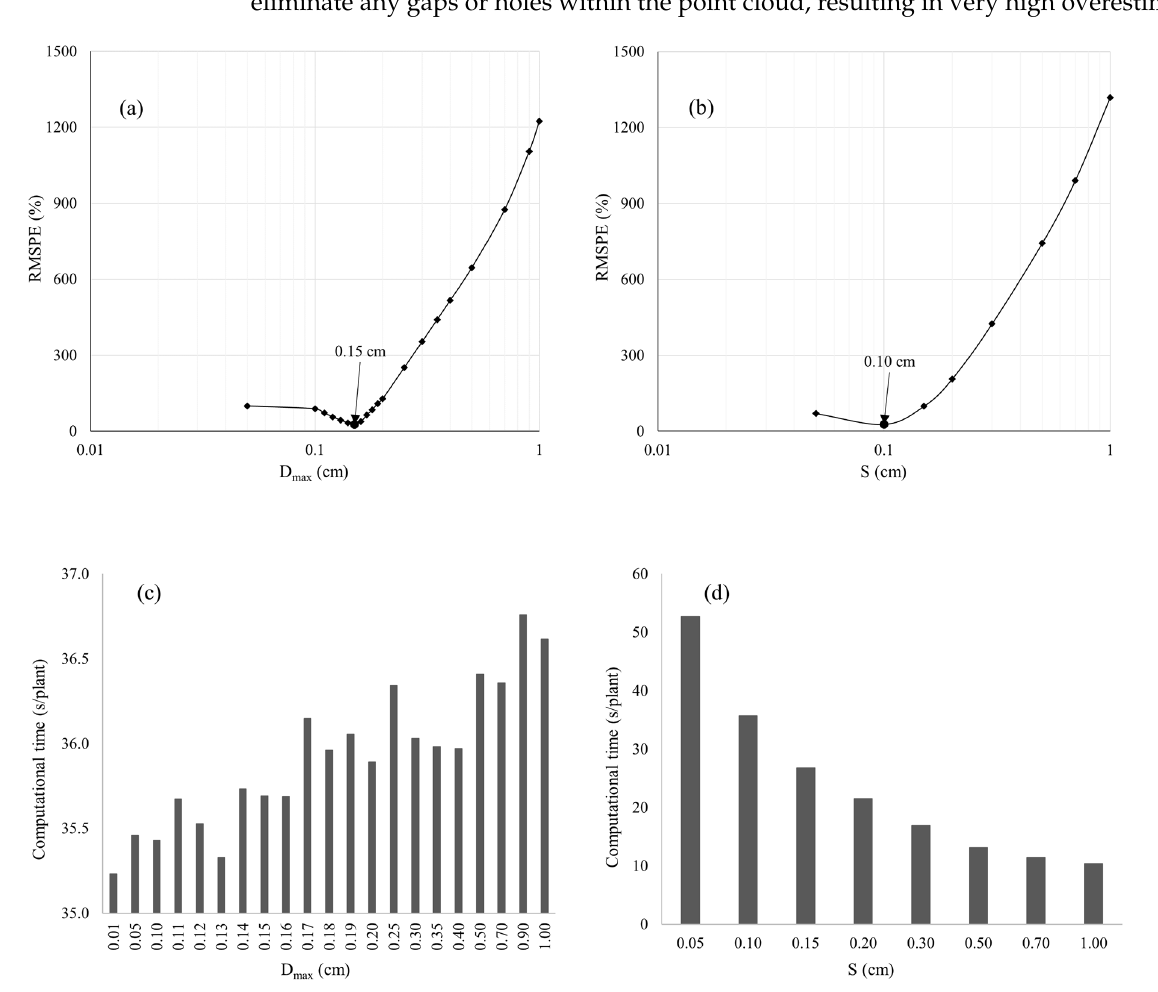
Figure 5. Changes in root mean squared percentage error (RMSPE) between reference strawberry plant ( n = 12) volume determined by water displacement technique and 3D point cloud estimated volume using slicing and summing slice volume approach considering varying D max for S = 0.1 cm ( a ) and varying S for D max = 0.15 cm ( b ). Computational time plotted for corresponding cases ( c ) and ( d ). For enhancing readability, the x -axis is shown on log scale in the first two figures.